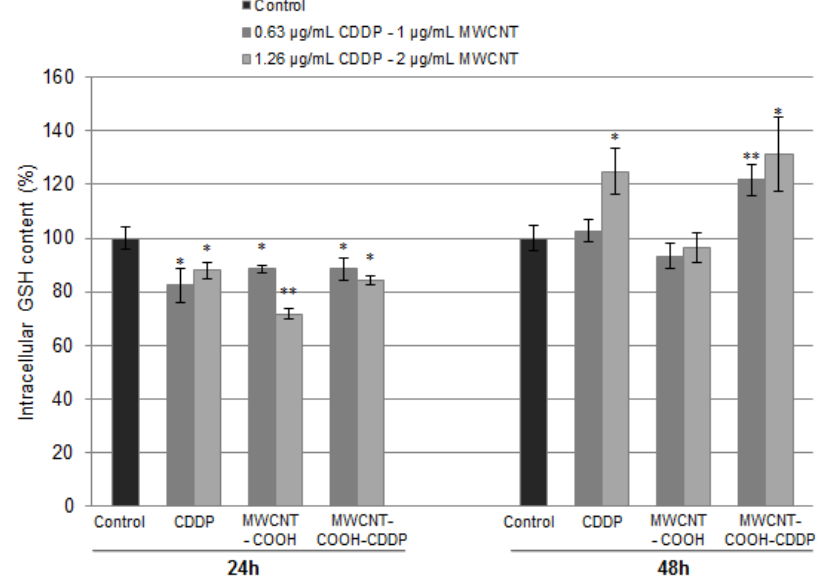
Figure 10. Intracellular GSH content after breast cancer cell exposure to MWCNTs (1, 2 µ g/mL) and CDDP (0.63, 1.26 µ g/mL) for 24 h and 48 h. The results are calculated as the mean ± SD of 3 replicates and represented relative to control. * p < 0.05, ** p < 0.01 vs. control.